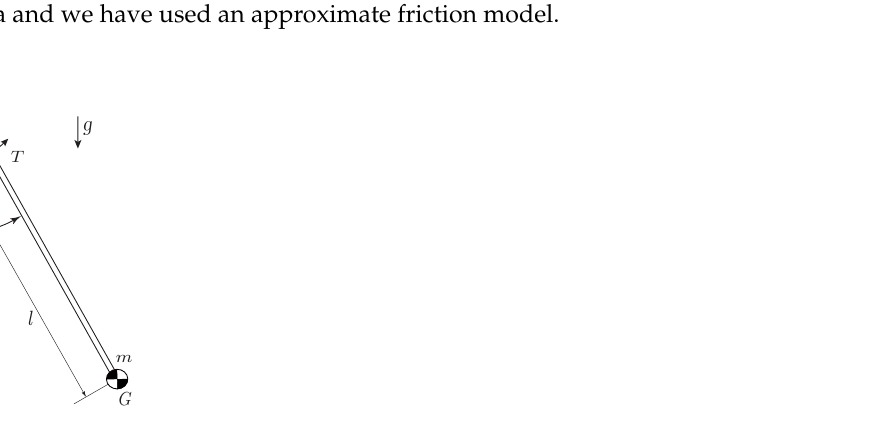
Figure 2. Simple pendulum: This consists of a massless rod of length (cid:96) with a point mass m at the end G . The pendulum is controlled by a torque T at the hinge joint H . Gravity g points downward. The angle between the vertical and pendulum is θ measured in the counter-clockwise